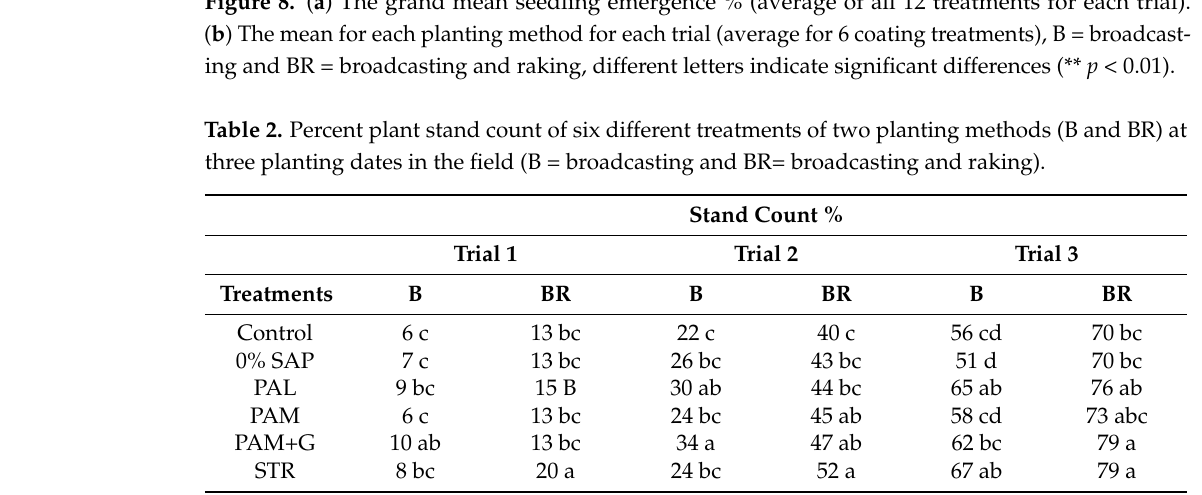
Within a column, mean values with different letters are statistically different ( p <